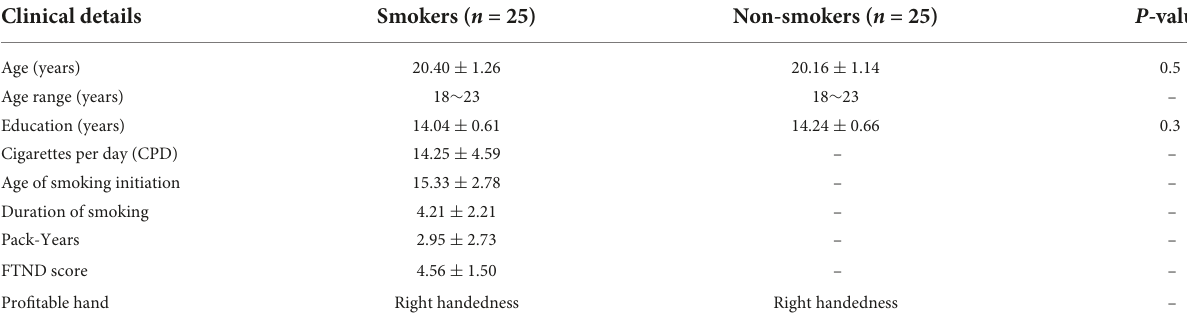
TABLE 1 Demographic and smoking characteristics of the